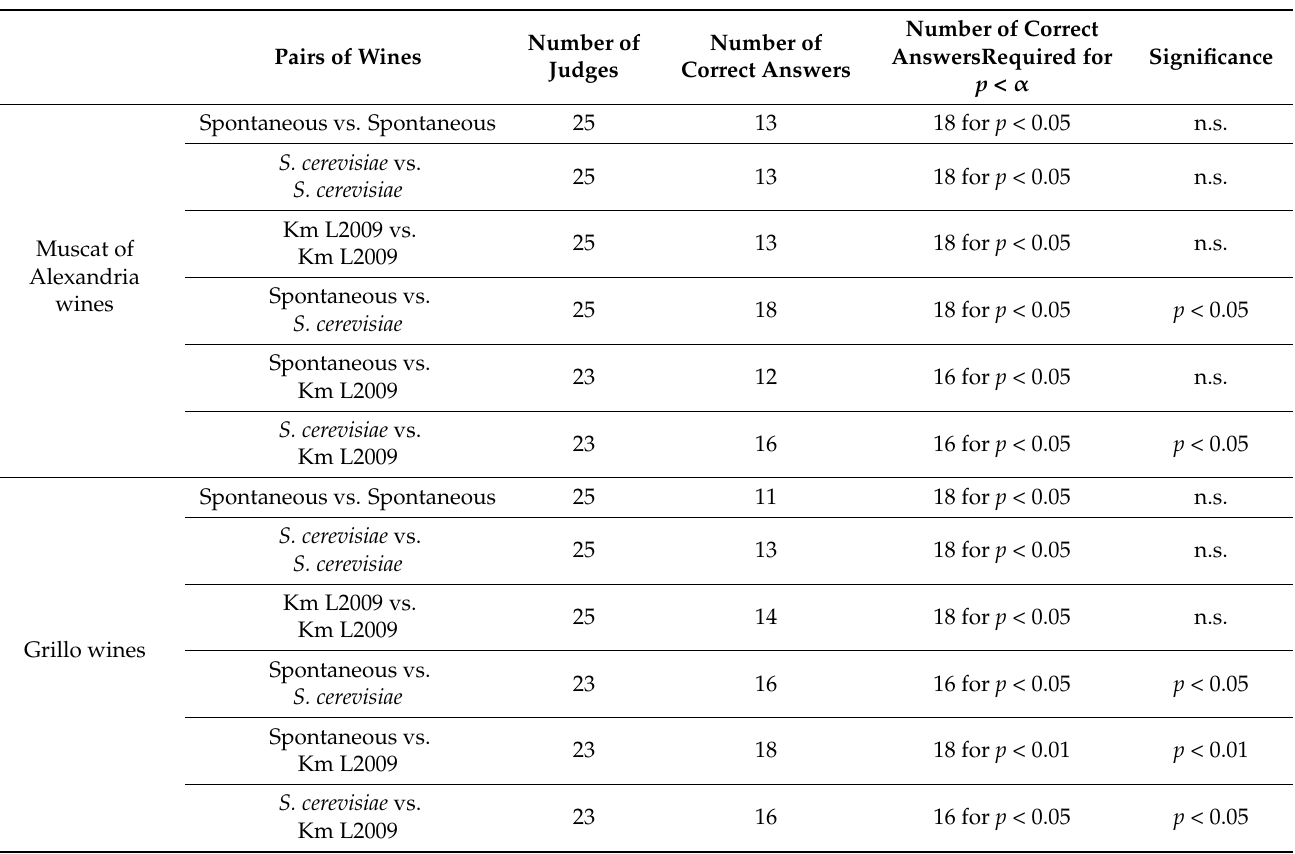
Table 6. Results of duo-trio test performed with Muscat of Alexandria (top) and Grillo (bottom) wines produced by spontaneous fermentation (Spontaneous), by inoculum with the Saccharomyces cerevisiae commercial strain QA23 ( S. cerevisiae ) and with Kluyveromyces marxianus Km L2009 strain (Km L2009). p : p -value; α : significance level; n.s.: not significant. Number of Correct Number of Number of Pairs of Wines AnswersRequired for Judges Correct Answers p < α